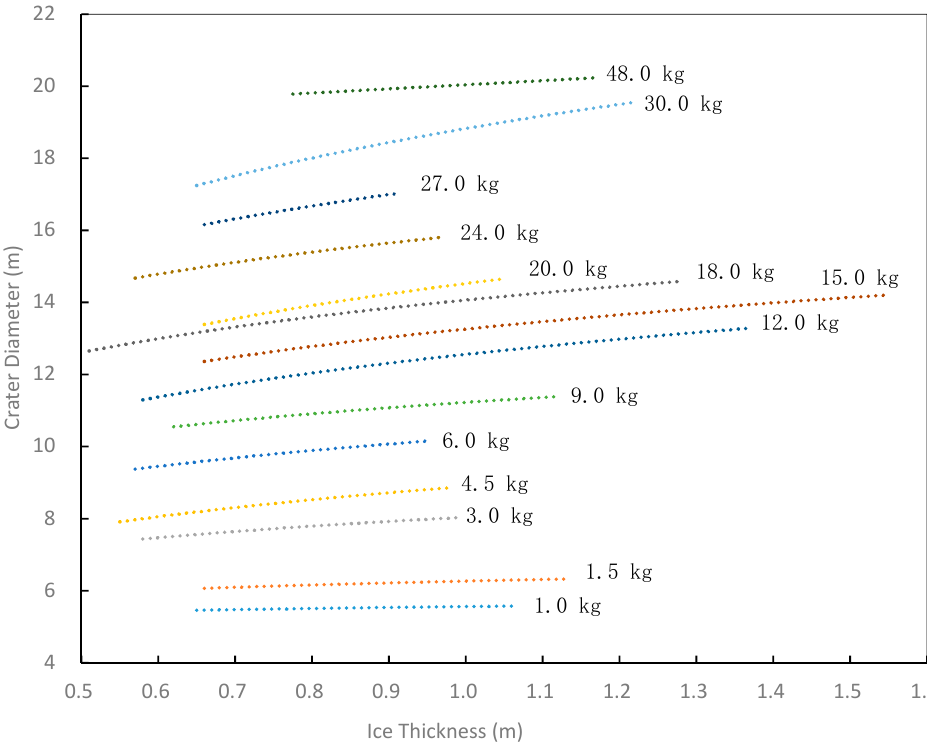
Figure 5. Relationship between measured blasting crater diameter and ice cover thickness.